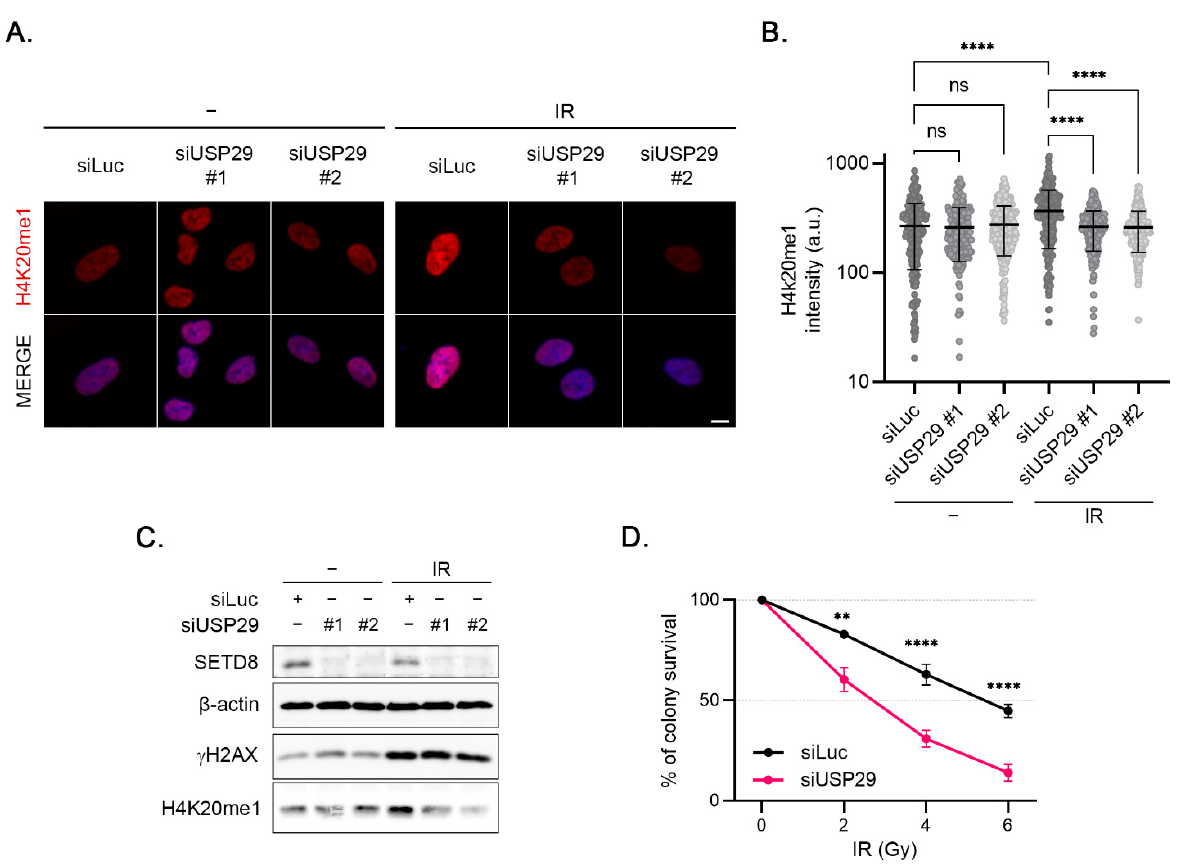
Figure 5. USP29 controls IR-induced H4K20 monomethylation and cell survival. ( A ) U2OS cells were transfected with Luc or the indicated USP29 siRNA oligonucleotides, treated with IR (4 Gy, 1 h), and analyzed for nuclear H4K20me1 intensity by IF. Representative images are shown. Scale bar, 10 µm. ( B ) Quantification of nuclear H4K20me1 intensity per cell of two independent experiments. ( C ) U2OS cells were transfected and treated as in ( A ). Cells were lysed and extracts were analyzed by Western blot with the indicated antibodies. ( D ) Colony formation of HeLa cells, depleted of Luc or USP29 and treated with the indicated doses of IR. Shown is the relative survival as compared to the undamaged control. Error bars represent the SEM of four individual